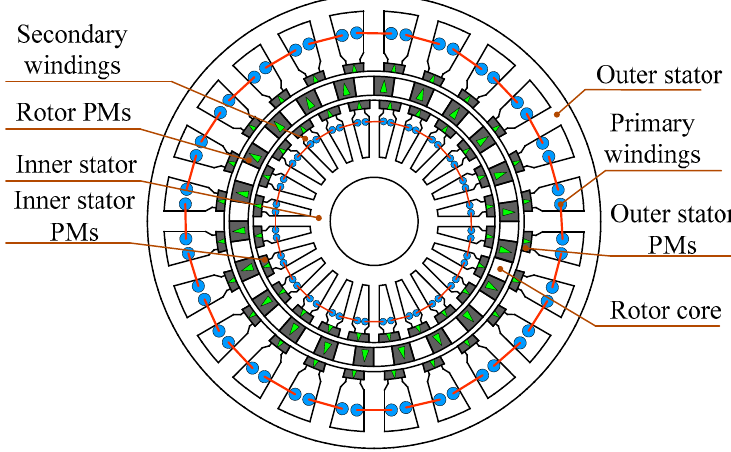
Figure 1. Configuration of proposed triple-permanent-magnet-excited vernier with double-stator (TPMEV-DS) machine.